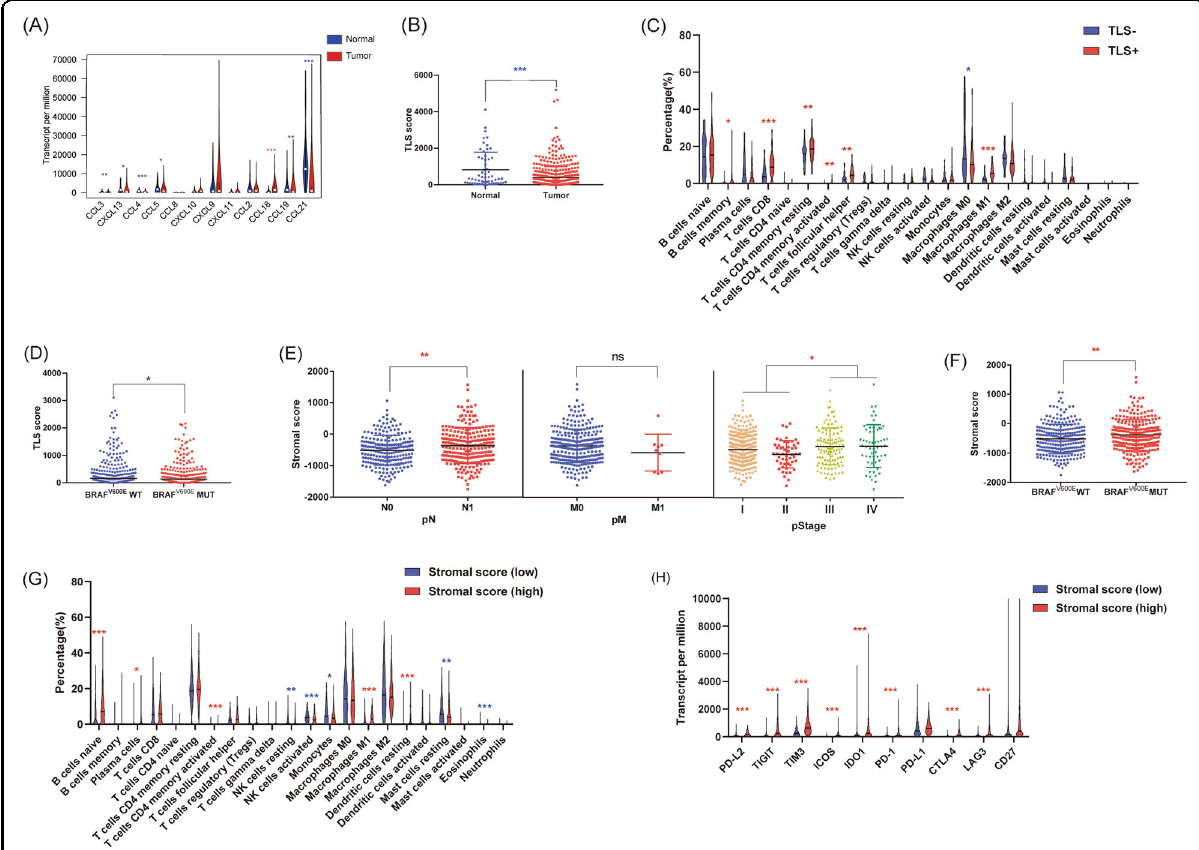
Fig. 5 Tertiary lymphoid structures and stromal cells in papillary thyroid cancer. A Expression of tertiary lymphoid structure (TLS)-associated chemokines in PTC and healthy thyroid tissues. B TLS score of PTC and healthy thyroid tissues. C Correlation of TLS score and immune cells in PTC. D Correlation of TLS score and BRAF V600E mutation in PTC. E Correlation of the stromal score and different pathological stages of PTC. F Correlation of stromal score and BRAF V600E mutation in PTC. G Correlation of stromal score and immune cells in PTC. H Correlation of stromal score and immune checkpoints in PTC. (* P < 0.05, ** P < 0.01, *** P <